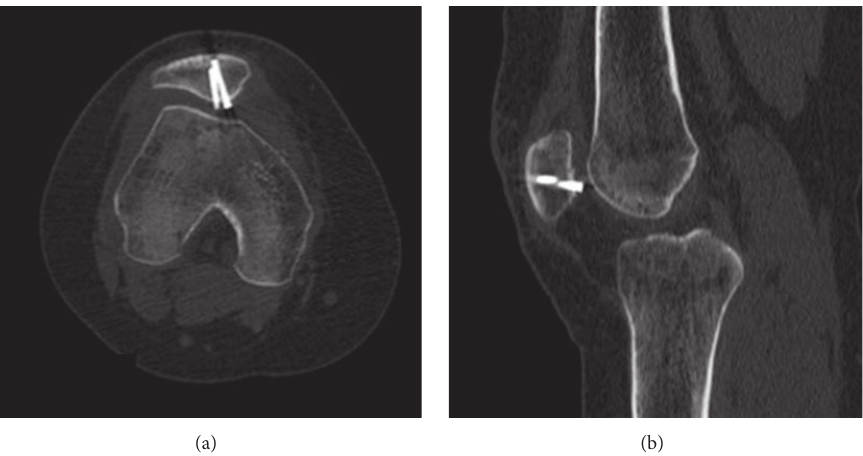
Figure 3: CT showing the relationship between the patellofemoral joint and implant: axial (a) and sagittal (b) slices.